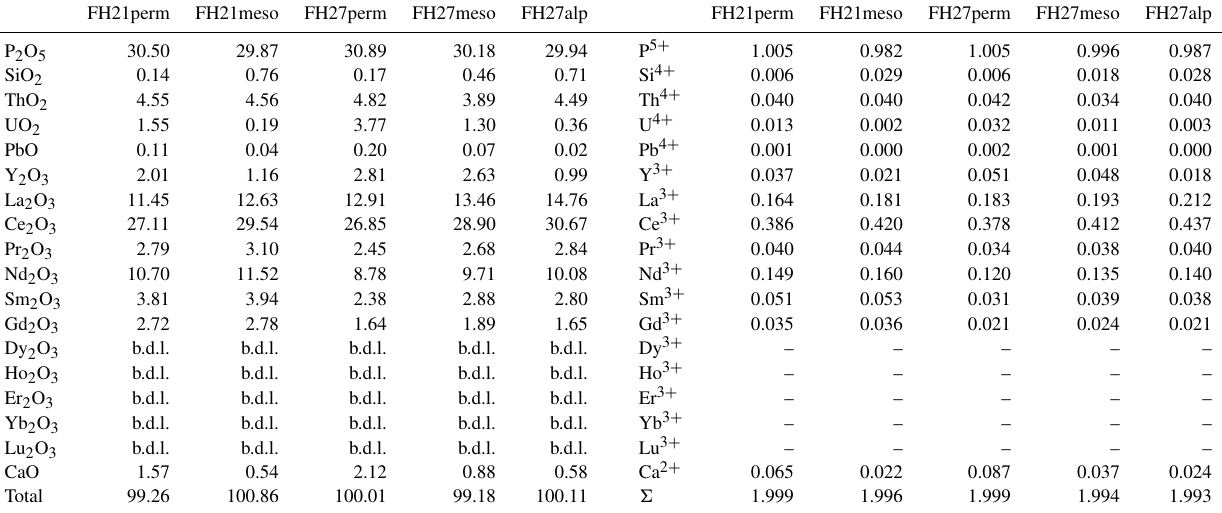
Figure 4. (a–g) Semi-quantitative element distribution maps for the monazite core from sample FH21 obtained by EMP (unit: counts; compare Fig. 2e). (h) BSE image showing measurement points for EMP dating and their corresponding age population. Table 2. Representative monazite analyses (left: wt%; right: apfu) obtained by EMP (b.d.l.: below detection limit). FH21perm